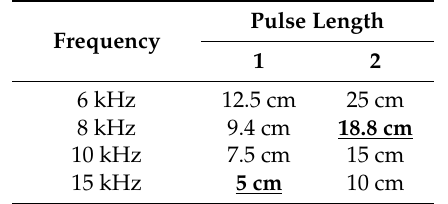
1. the paleo Elbe valley (PEV) 2. the Sylt Outer Reef (SOR) The PEV reveals low backscatter data representing muddy fine sands (mean 100 µ m). The SOR located east of the valley shows small-scale changes of high, medium and low backscatter. Low-backscatter data represent fine sands (mean 190 µ m) and medium backscatter rippled medium sands (mean 320 µ m). High backscatter represents two different coarse sediments (Figure 3): 1. lag deposits: poorly sorted sediments with a matrix of fine sand to gravel with pebbles, cobbles, boulders and blocks up 1.5 m in size 2. gravelly substrates: large ripples (up to 30 cm in height) of sandy gravel to gravel (described in more detail by Papenmeier et al.